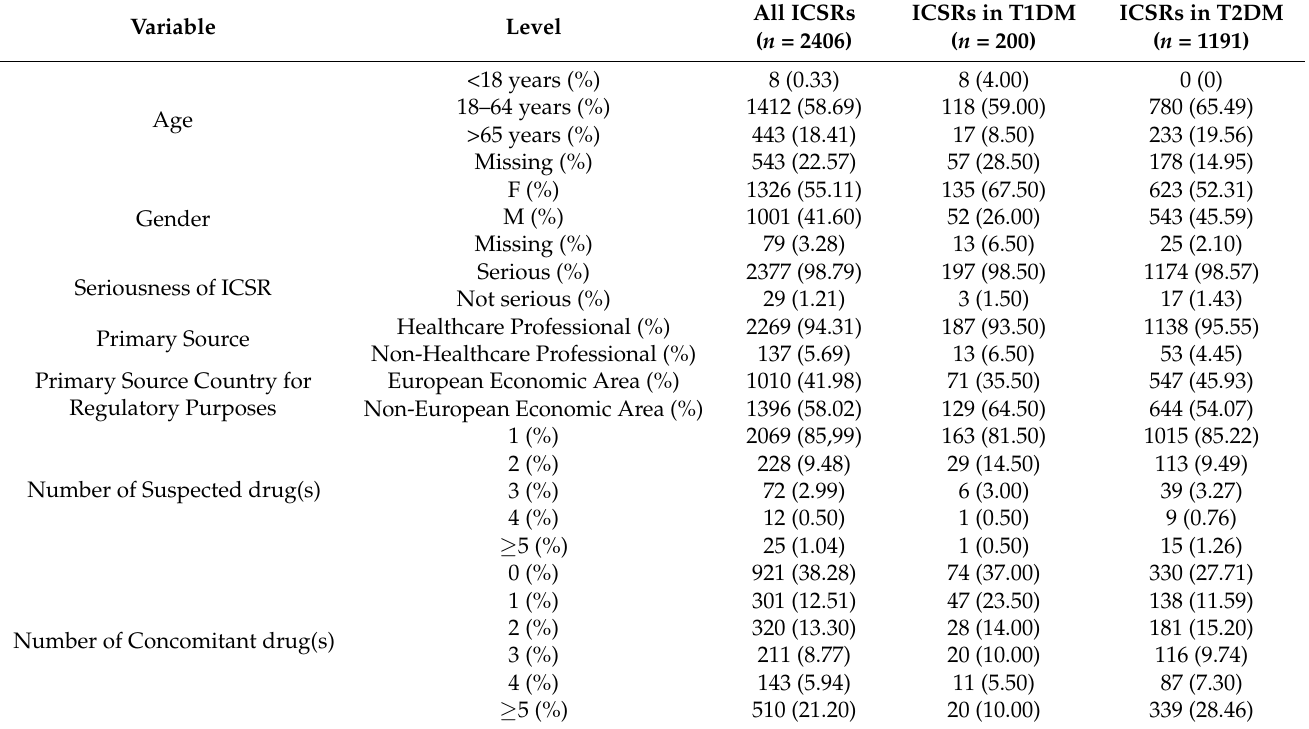
Table 1. Distribution for age, gender, seriousness, primary source, primary source country, number of suspected drugs, and number of concomitant drugs of Individual Case Safety Reports (ICSRs) report- ing at least one event classifiable as ketoacidosis and having dapagliflozin as suspected drug among those reported in Eudravigilance from the date of marketing authorization to 11 September 2021.